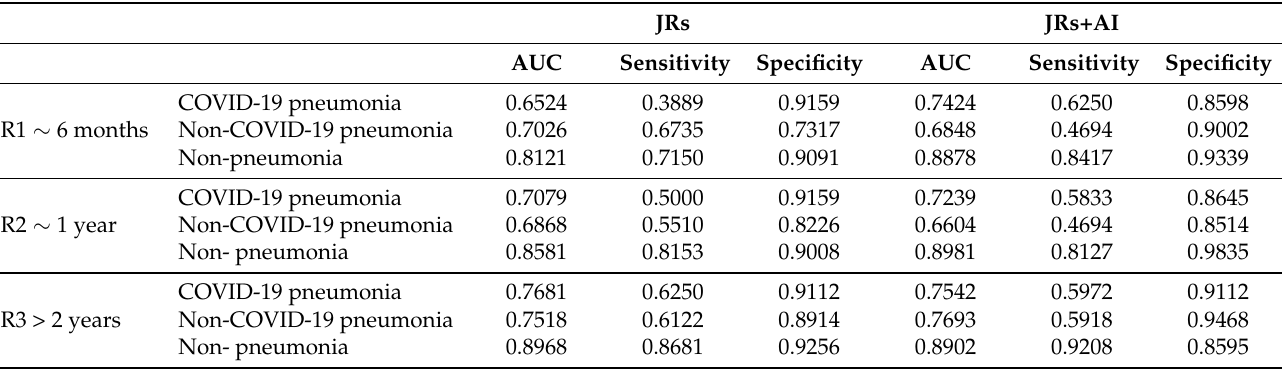
Table 5. Performance comparison for each class on the test set and the external test set in terms of AUC scores, Sensitivity, and